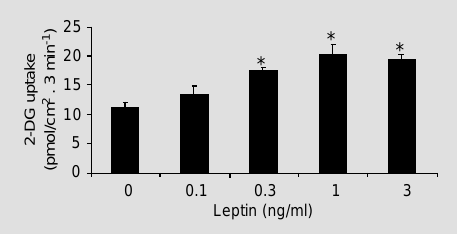
Figure 1 - 2-Deoxy-glucose (2- DG) uptake (pmol/cm 2 . 3 min -1 ) in isolated adipocytes in the presence of leptin. Each point represents the mean value ± SEM of three different incuba- tion experiments with five samples in each leptin group. Adipocytes were extracted from male albino rats (Wistar strain), cultivated for 15 h in the pres- ence and absence of leptin and subsequently assayed for 2-DG transport. *P<0.05 compared to basal levels (no leptin)